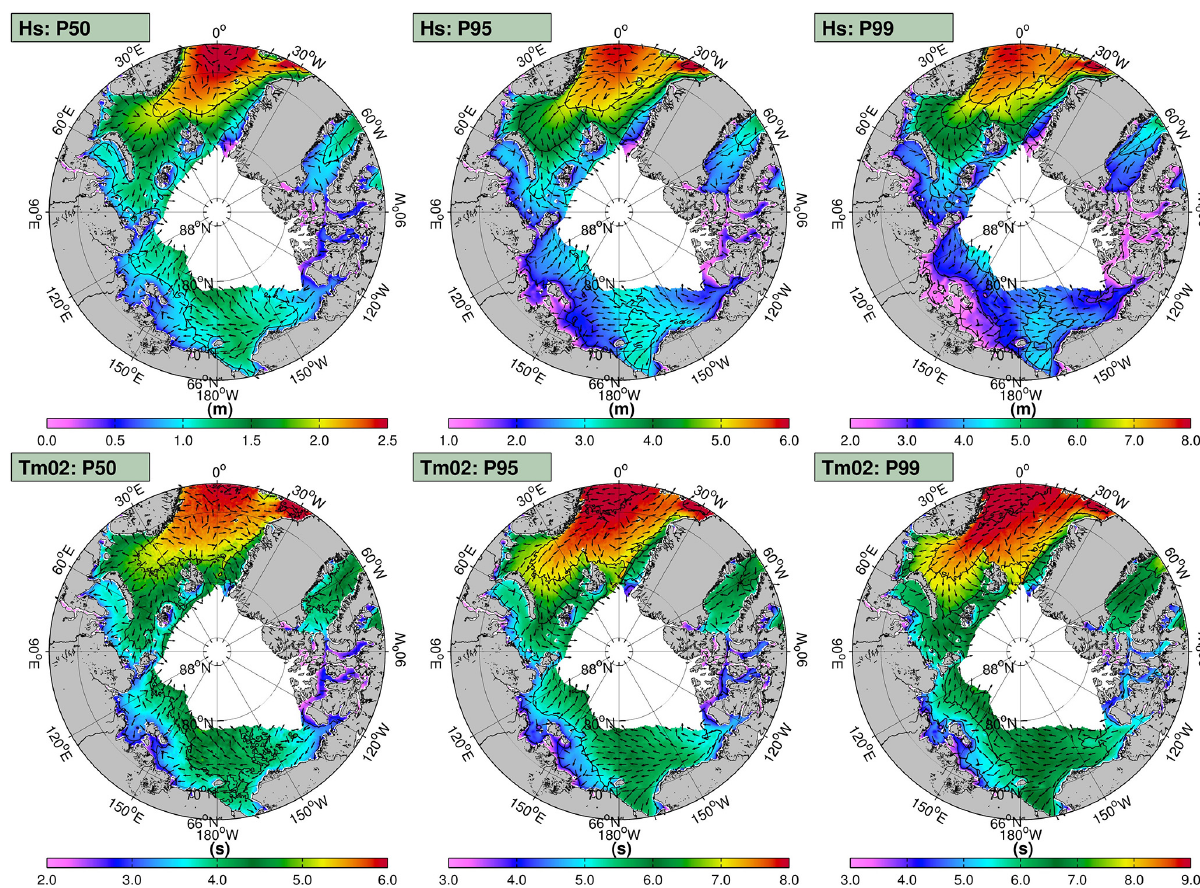
Figure 6. Significant wave height percentiles (top panels) and corresponding averaged wave periods (bottom panels) and directions